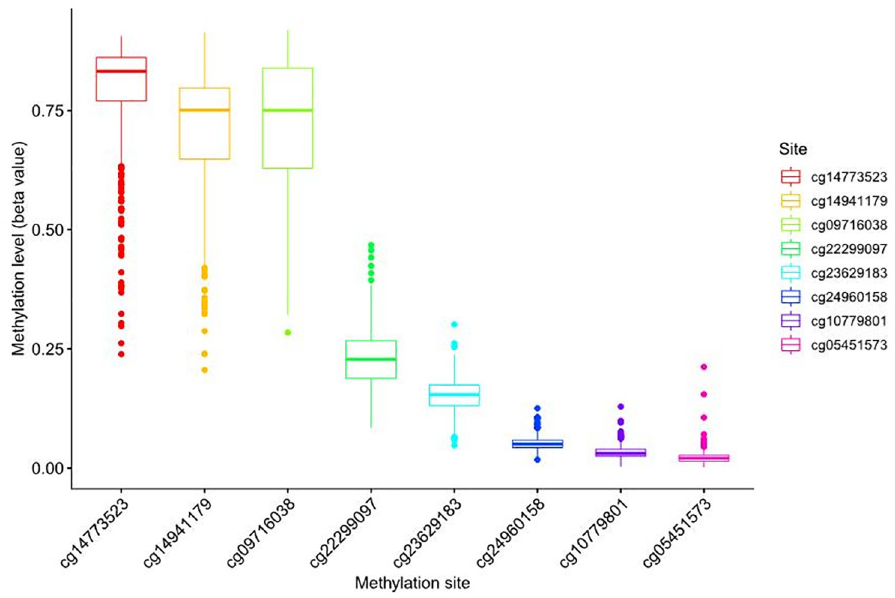
Fig 3. Box plot of methylation levels at RIOX2 gene-related sites in lung adenocarcinoma. The abscissa represents RIOX2 related sites, and the ordinate represents site methylation levels.